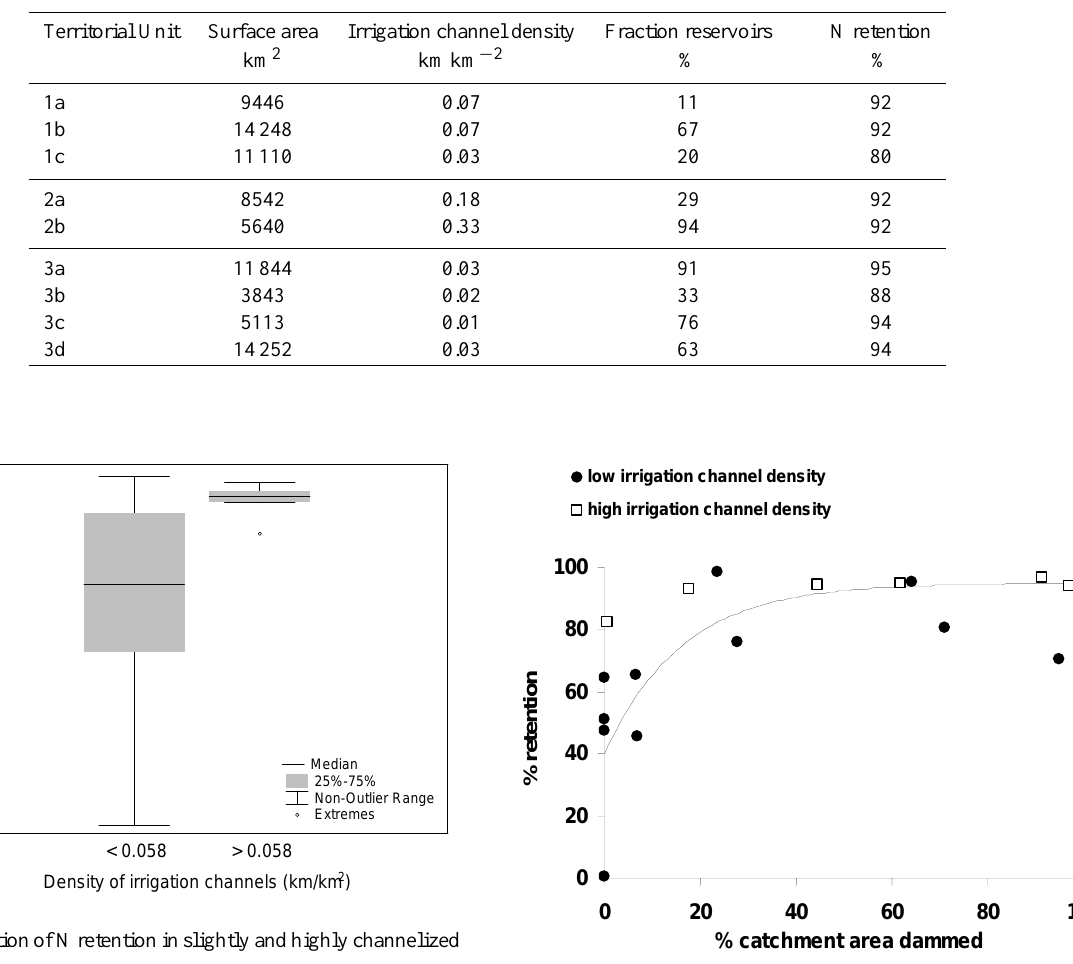
Figure 7. Calculated retention for 21 sub-catchments in the Ebro basin plotted against the percentage of basin area drained into a reservoir. Catchments with high irrigation channel density (i.e. > 0.058 km/km²) are represented as open squares.